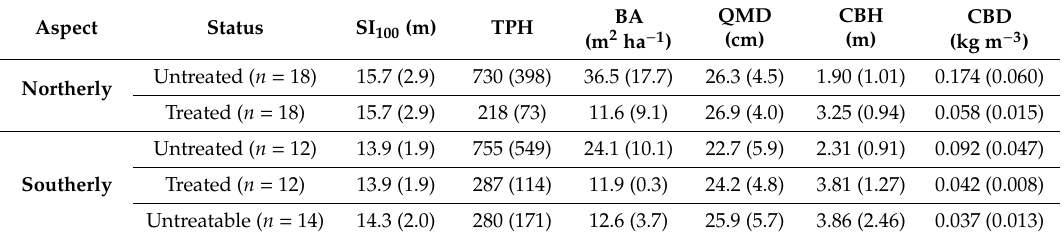
Figure 1. Location of our ( a ) 4800 ha study area in context of the Arapaho-Roosevelt National Forest and similar, dry forest cover types of the northern Front Range, CO, along with the ( b ) elevation and ( c ) the stand delineation of the study area. Note that our simulated landscape in ( b , c ) is flipped on the x -axis such that x increases from east to west. Table 1. Summary of structural attributes for stands from the FIA database before and after simulated treatments. Columns are the mean (standard deviation) of site index, base age 100 (SI 100 ); trees per hectare (TPH); basal area per hectare (BA); quadratic mean diameter (QMD); canopy base height (CBH); and canopy bulk density